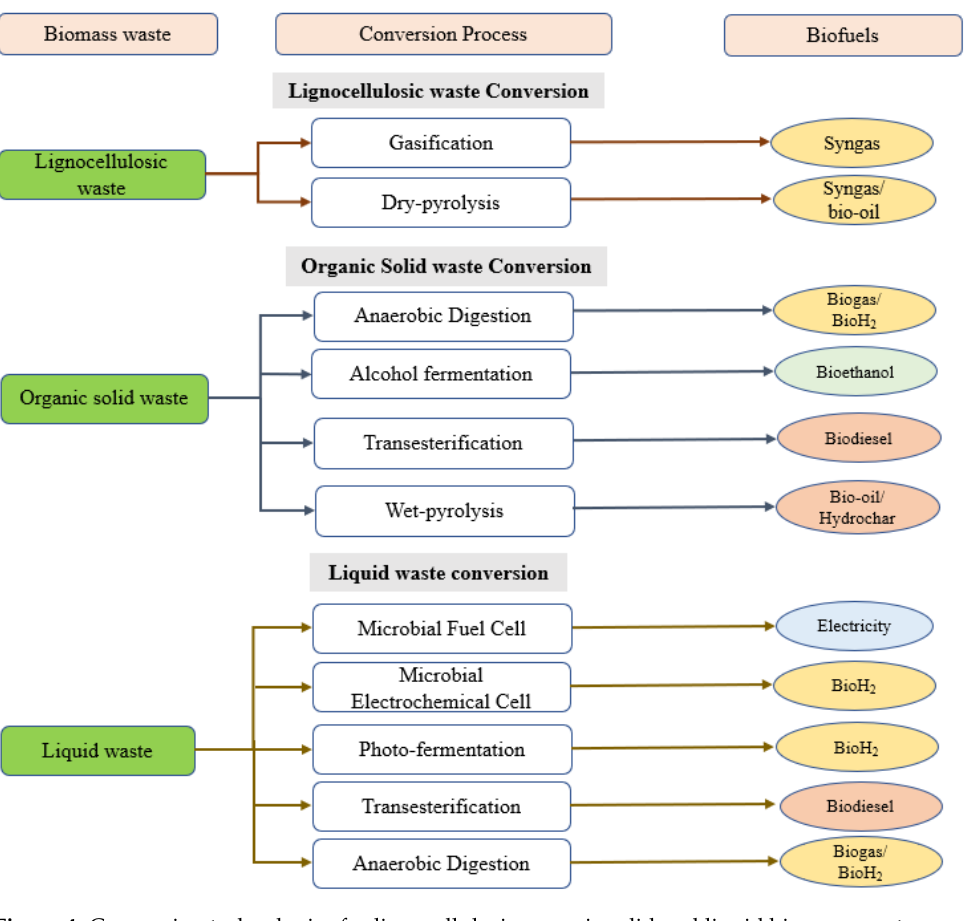
Figure 4. Conversion technologies for lignocellulosic , organic solid and liquid biomass waste .